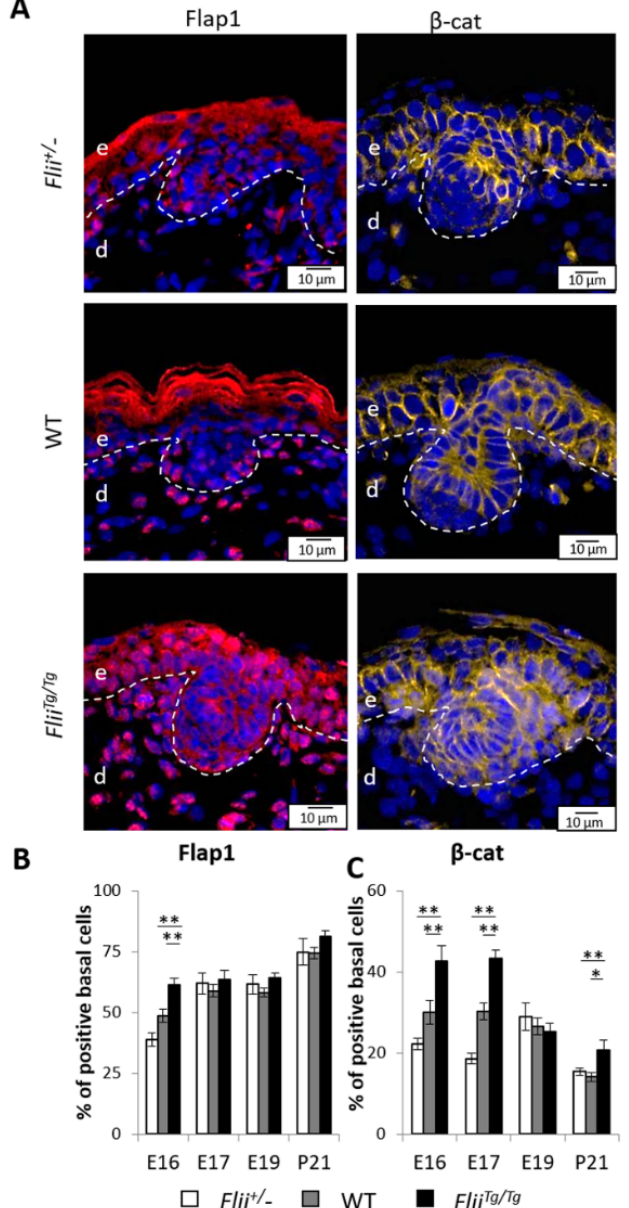
Figure 6. Expression of Flap1 and β -cat in the epidermis of mice expressing varying levels of Flii during late embryonic development. ( A ) Immunofluorescence of Flap1 and β -cat in developing epidermis at E16. Flap1 is shown as pseudo-stained red, and β -cat is shown as pseudo-stained yellow. Nuclear DAPI staining is shown as pseudo-stained blue. The epidermal-dermal junction is shown by white dash lines; e, epidermis; d, dermis. Scale bars, 10 μ m. Flii +/ − , Flii knockdown; WT, wild-type; Flii Tg / Tg , Flii overexpressing. Quantification of ( B ) Flap1 expression as % of positive cells with nuclear FLAP expression and ( C ) β -cat expression as % of positive cells with nuclear β -cat expression in total basal cells at E16, E17, E19 and P21. N = 6. Mean ± SEM. * p < 0.05. ** p < 0.005.